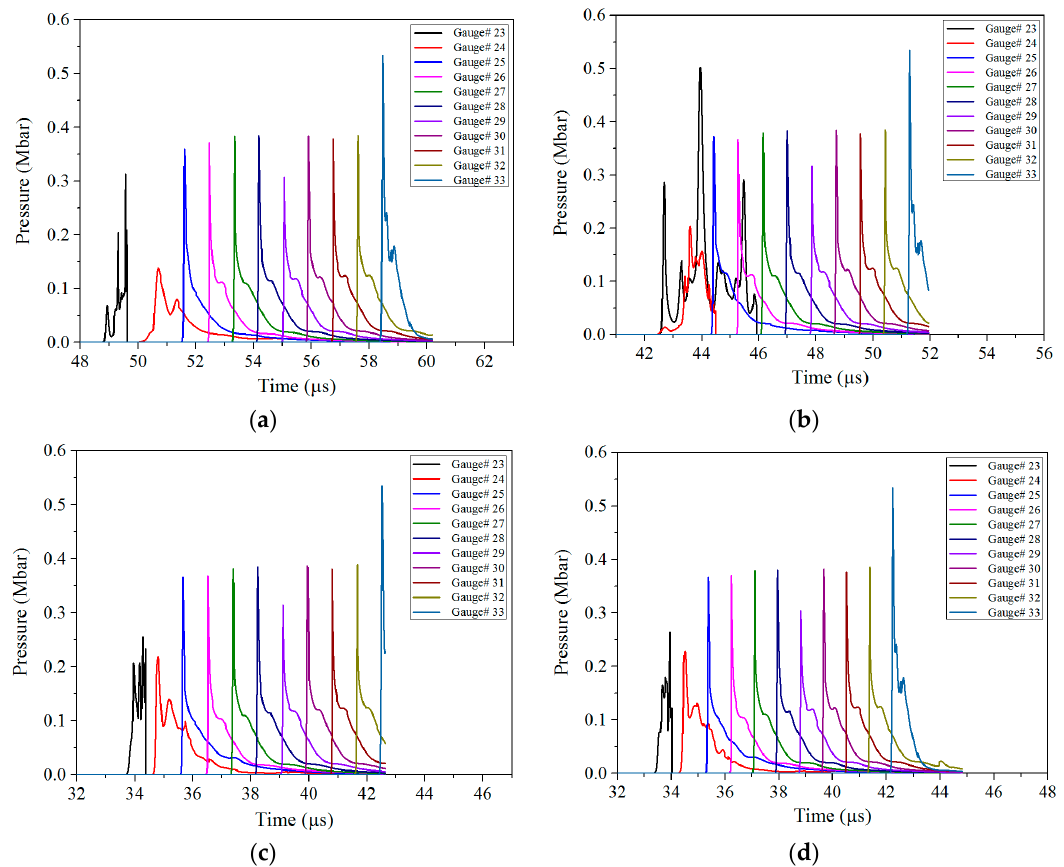
Figure 10. Pressure history curves of Gauss points in the sandwich charge for different liner materials: ( a ) copper; ( b ) floatglass; ( c ) Lucite; and ( d ) Plexiglas.